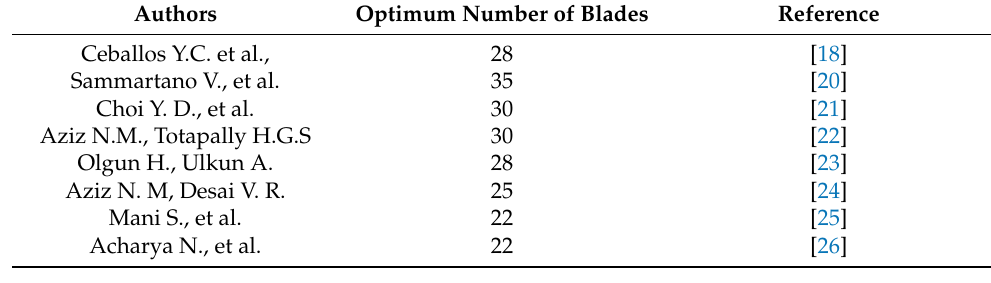
Table 3. Number of blades in a crossflow hydraulic turbine in different papers.